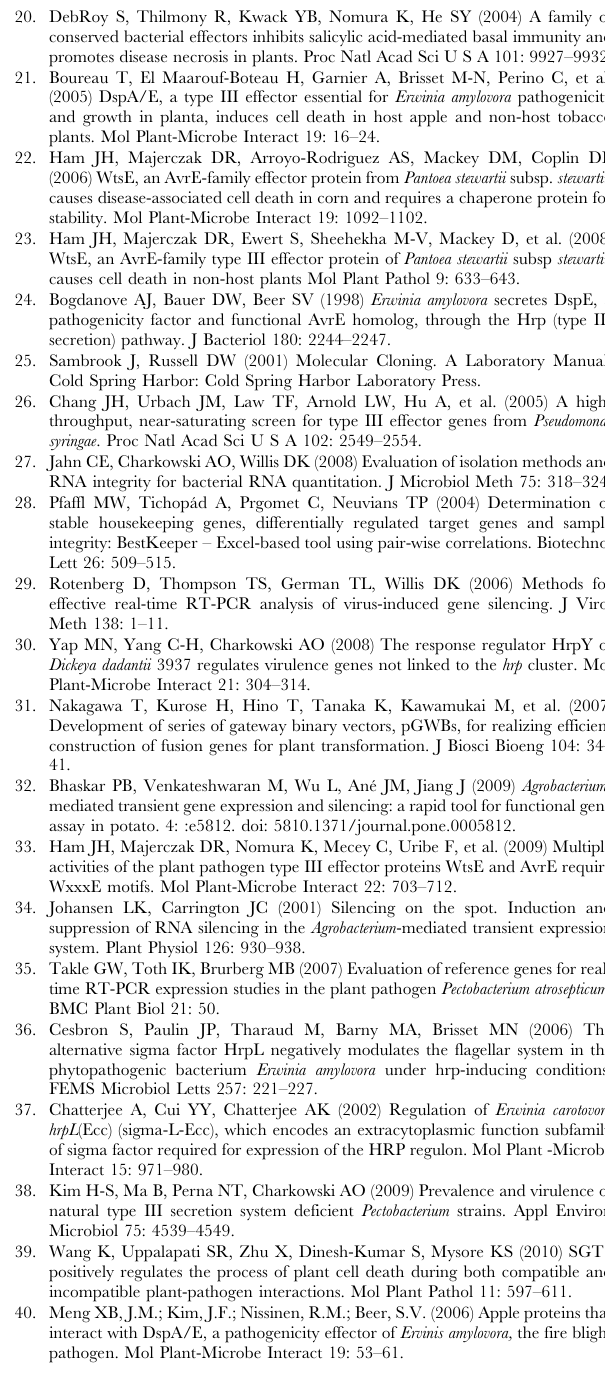
Table S2 Real-time RT-qPCR primer sequences and efficiency. Table S3 Primers for cloning DspE and